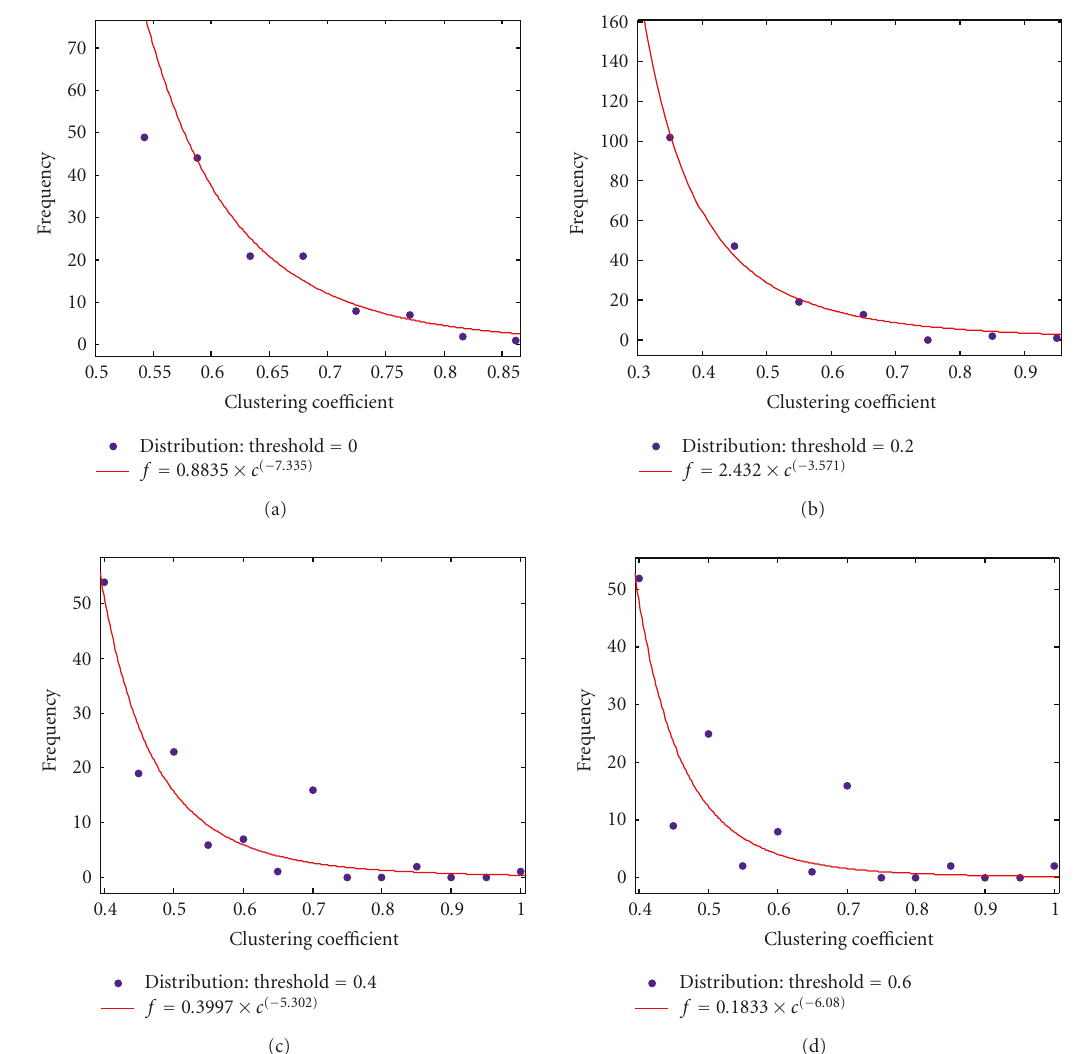
Figure 8: Power law for distribution of clustering coe ffi cient (MATLAB): simulation